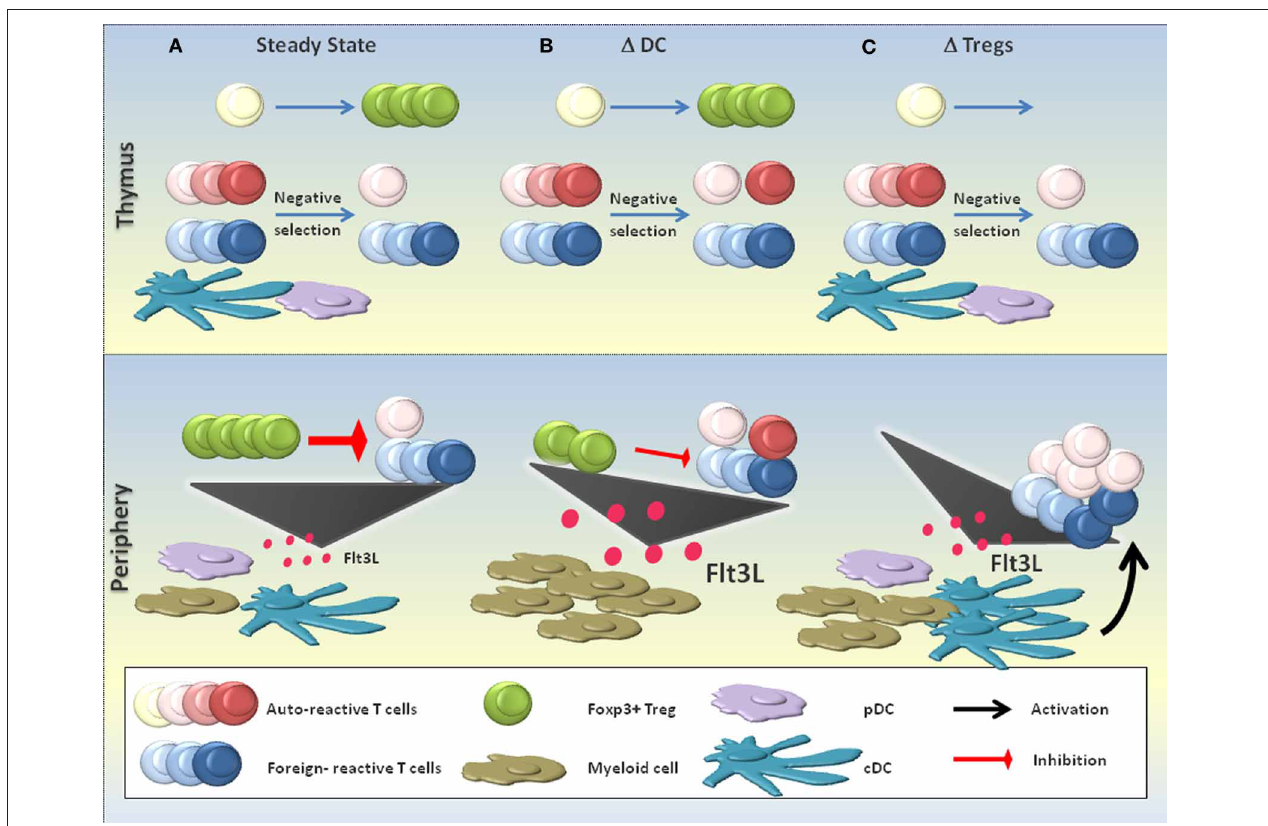
FIGURE 3 | DCs in the suppression of autoimmunity. The role of DCs in the suppression of autoimmunity is complex and a matter of discussion. (A) In the steady state, DCs are believed to contribute to the negative selection of autoreactive T cells. Few autoreactive T cell clones that escape negative selection can be efficiently controlled by Foxp3 + Tregs in the periphery, a process that critically depends on the continuous activation and homeostasis of Tregs by DCs. Equilibrium between the production of the myeloid growth factor FLT3L and its consumption maintains a constant number of DCs and other myeloid cells. (B) DC-deficient ( (cid:3) DC) mice may exhibit defective negative selection, resulting in the increased seeding of the periphery with self-reactive T cells. Additionally, the absence of peripheral DCs impairs Foxp3 + Treg homeostasis and activation, resulting in a